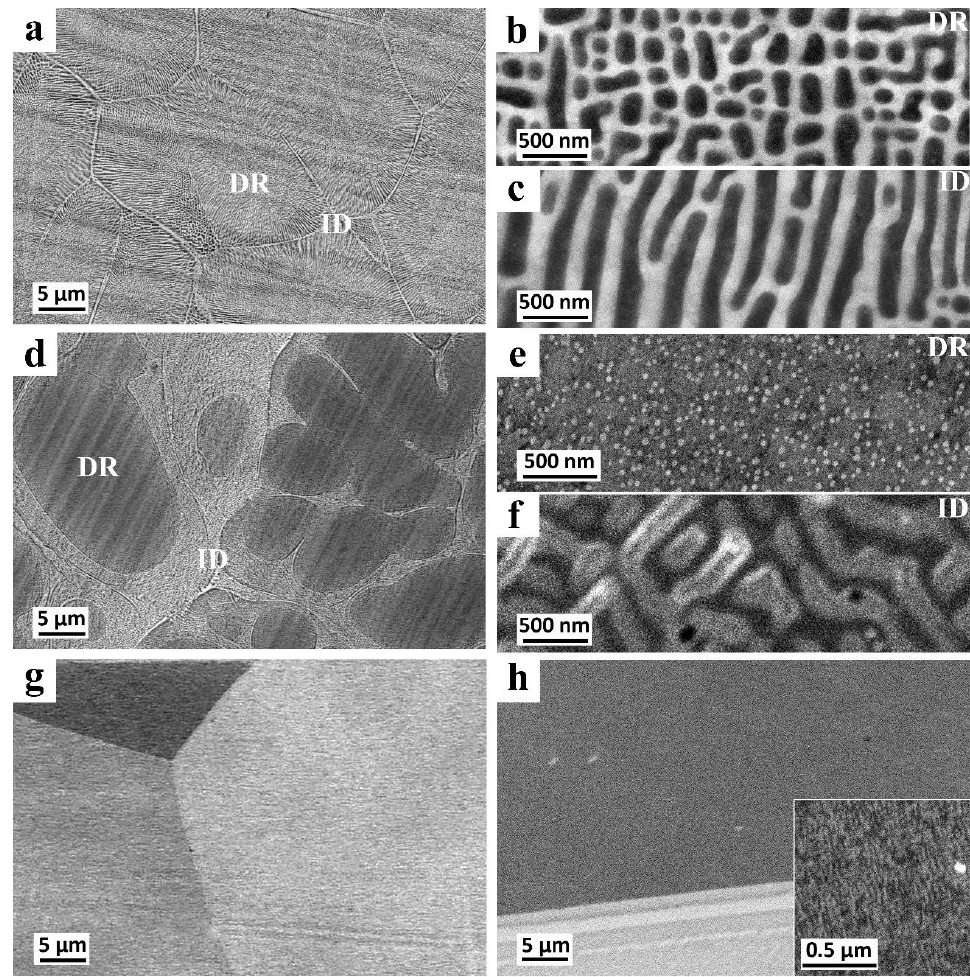
Figure 3. Scanning Electron Microscope (SEM) investigation of the quaternary alloys. ( a ) Back scattered (BS) SEM general view image of the AlCrFeNi (w/o Co) alloy. DR and ID areas are shown in ( b ) and ( c ) images, respectively. ( d ) (BS) SEM general view image of the AlCoCrNi (w/o Fe) alloy. DR and ID areas are shown in ( e ) and ( f ) images, respectively. ( g ) and ( h ) (BS) SEM general view images of the AlCoFeNi (w/o Cr) and AlCoCrFe (w/o Ni) alloys, respectively. Insert in ( h ) shows high resolution (using in-lens secondary electron detector) SEM image of the alloy without Ni.